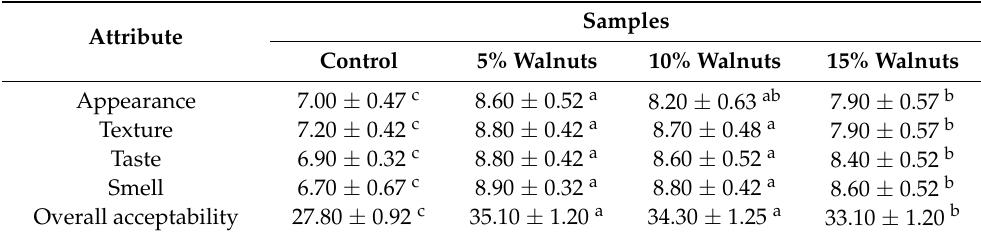
Table 4. Sensory characteristics of processed cheeses containing 0, 5, 10, and 15% walnut paste.